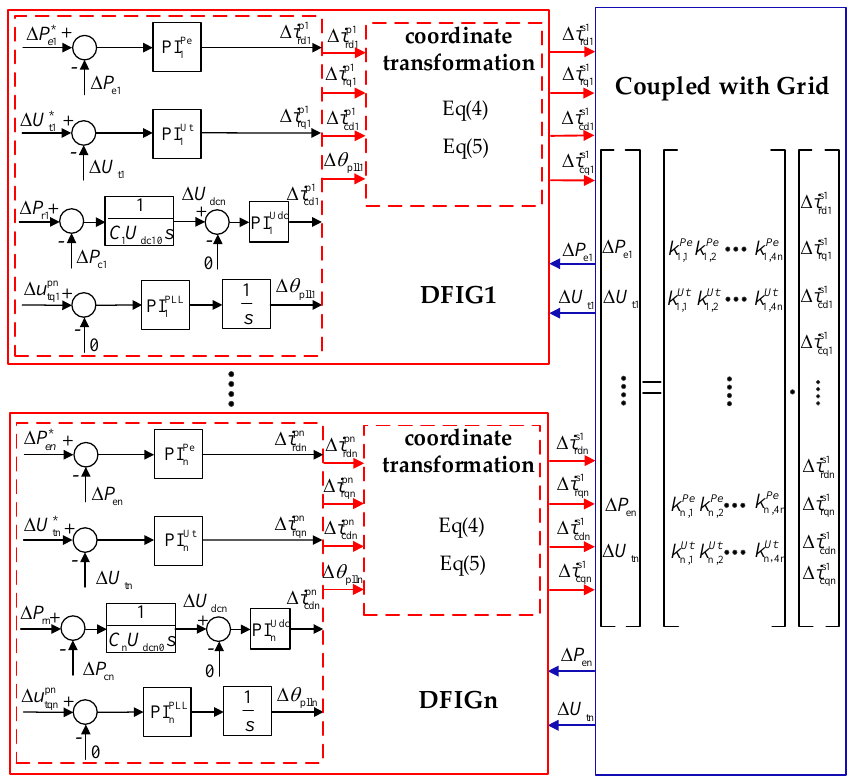
Figure 4. Diagram representation of small-signal model for multi DFIGs integrated into a weak grid.